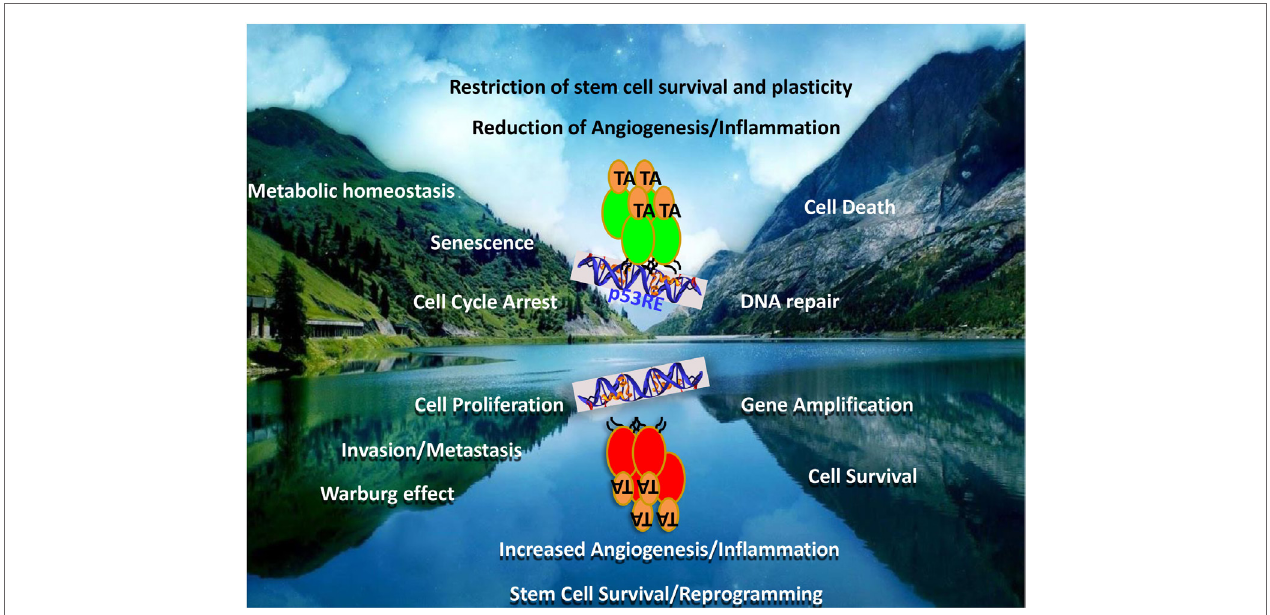
FiGURe 2 | Mutant p53 – the contrived oncogene . The figure represents a mirror image of the functions of the wild-type and mutant p53 proteins. While wild-type p53 is a tumor suppressor, the mutant form represents not only a loss of these functions but also the acquisition of directly opposite functions. Many of the tumor-suppressor functions and the counteracting oncogenic functions by mutant p53 are represented as mirror-image pairs: cell death/cell survival; cell cycle arrest/cell proliferation; DNA-repair/genomic instability; senescence/invasion and metastasis; metabolic homeostasis/Warburg effect; restriction of angiogenesis and inflammation/increased angiogenesis and inflammation; restriction of stem cell plasticity and survival/increased reprograming and expansion, to highlight a